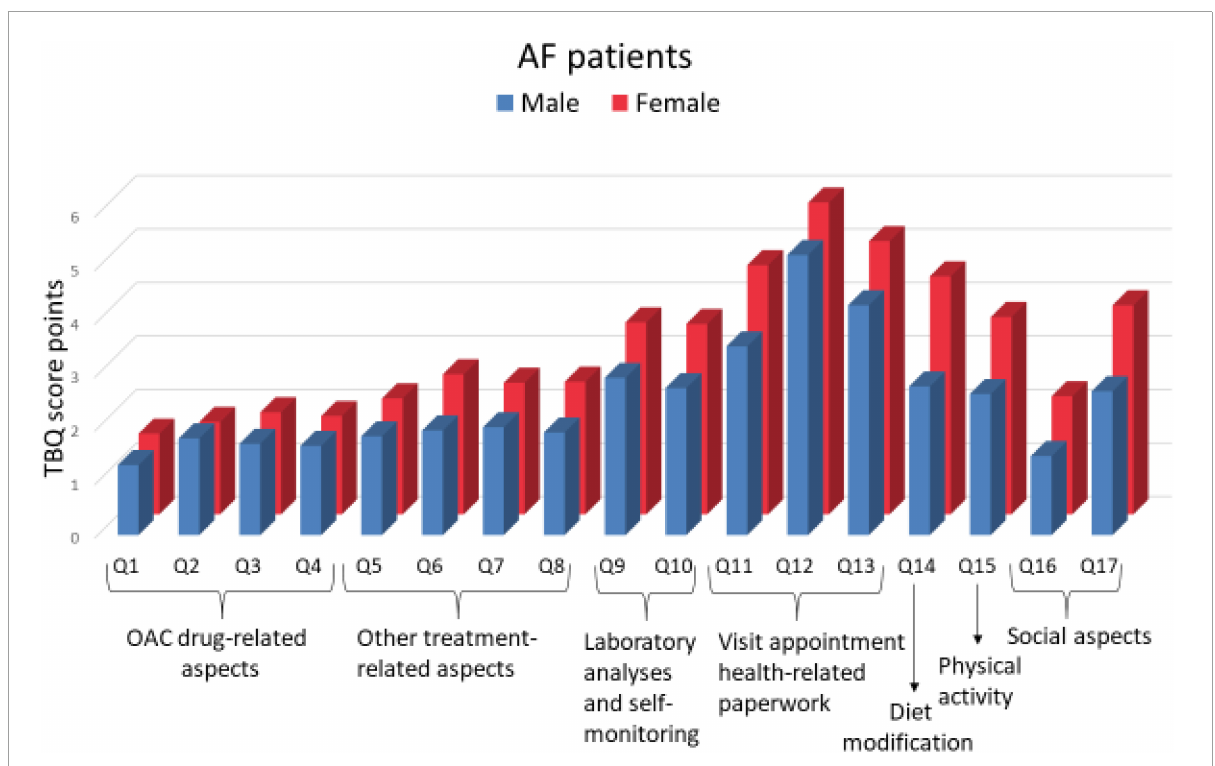
FIGURE3 Sex difference in specific management aspect-related treatment burden. AF, atrial fibrillation; TBQ, treatment burden questionnaire; Q, question; OAC, oral anticoagulant.